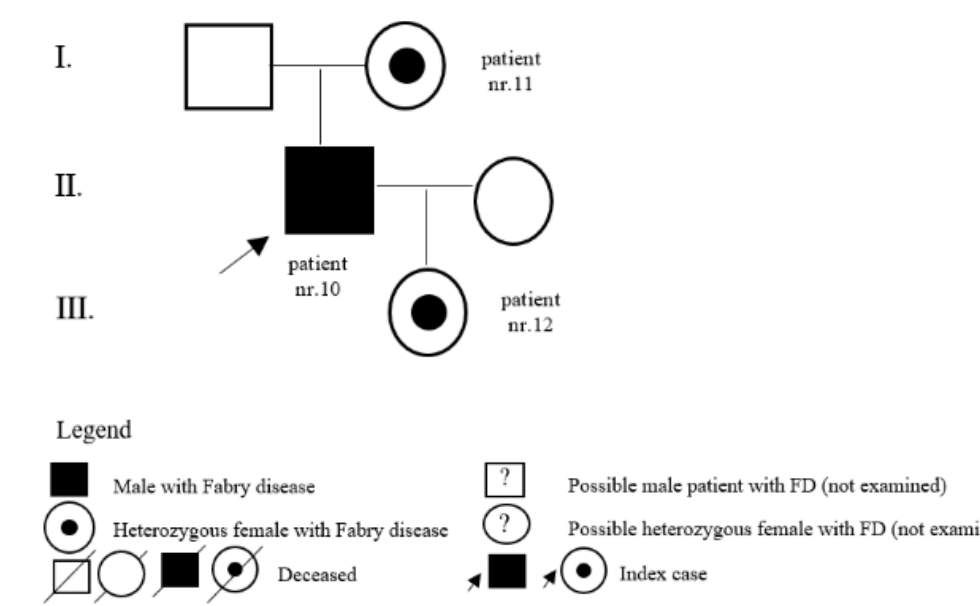
Figure 3. Pedigree of family with undescribed mutation c.736delA.